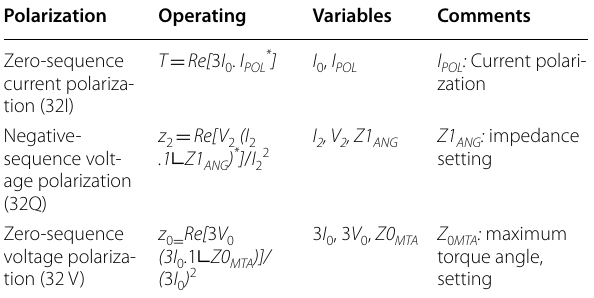
Table 3 Polarization for zero- and negative-sequence